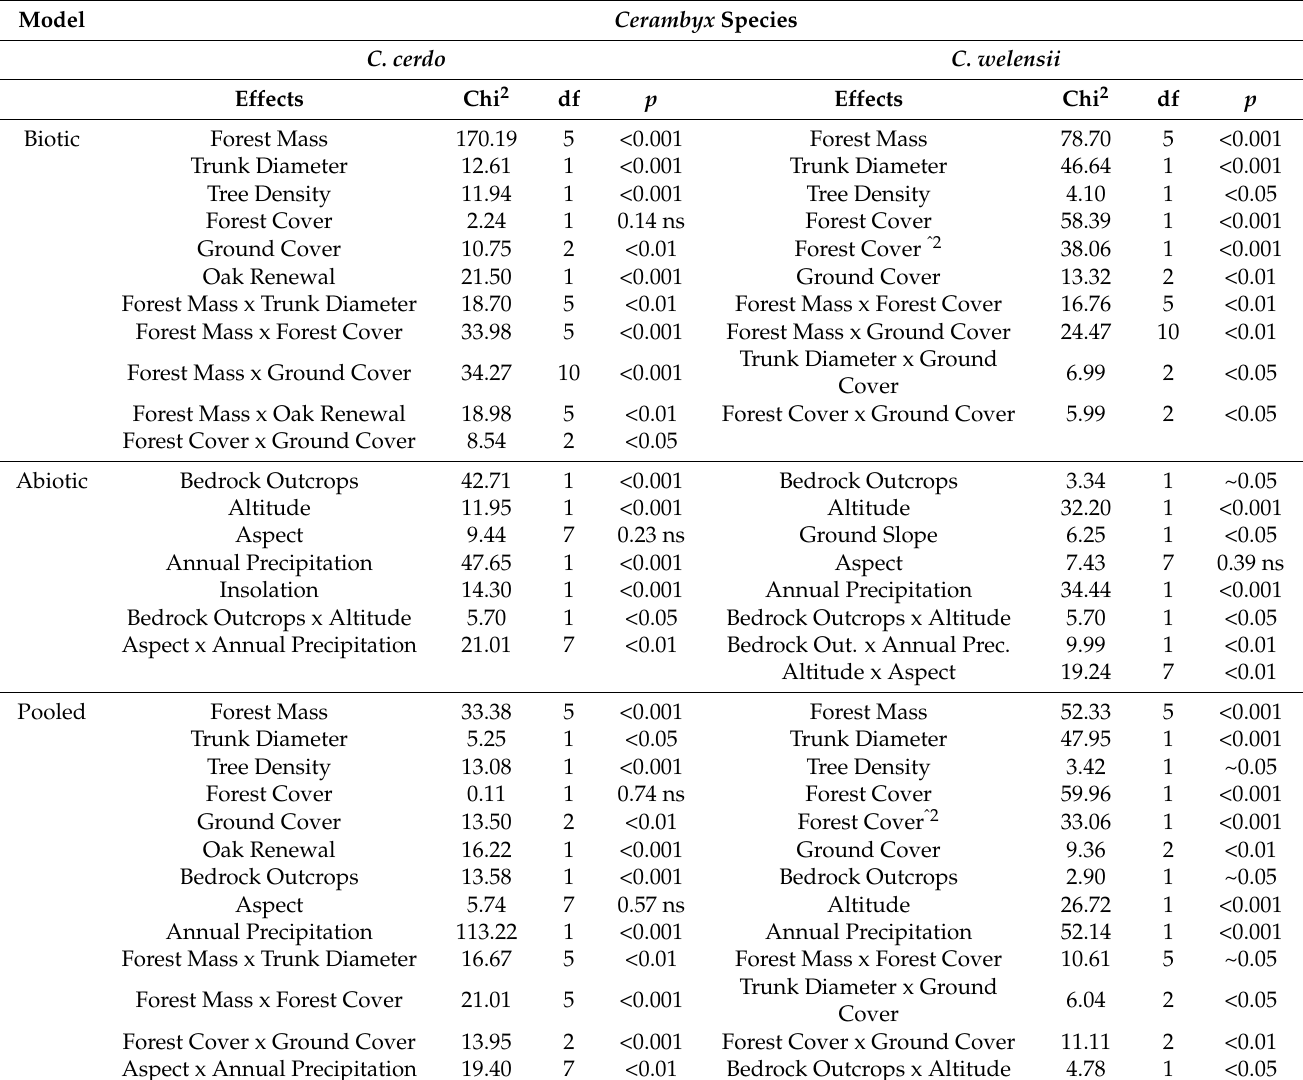
Table 3. Analysis of deviance table (Type II Wald Chi-square tests) from the best GLMMs computed to predict the abundance of each Cerambyx species ( C. cerdo and C. welensii ) in the wild. Three models were built per species with the predictor variables selected within either biotic, abiotic, or pooled